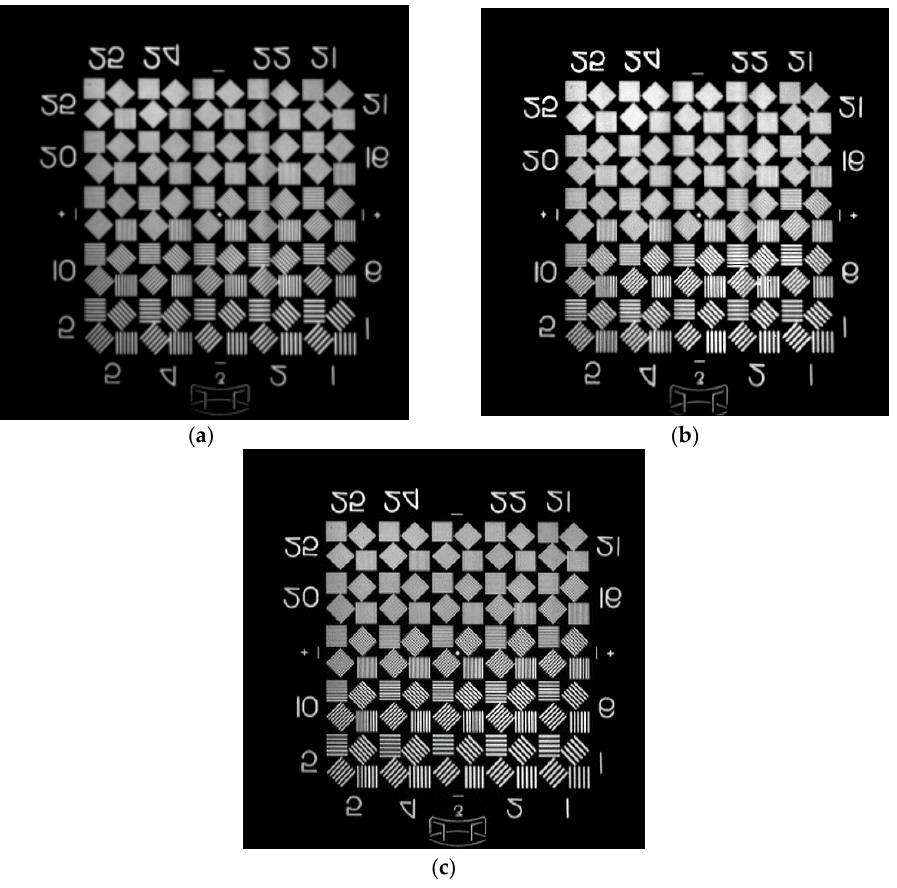
Figure 13. Experimental results from subpixel imaging. ( a ) Origin image; ( b ) Results from